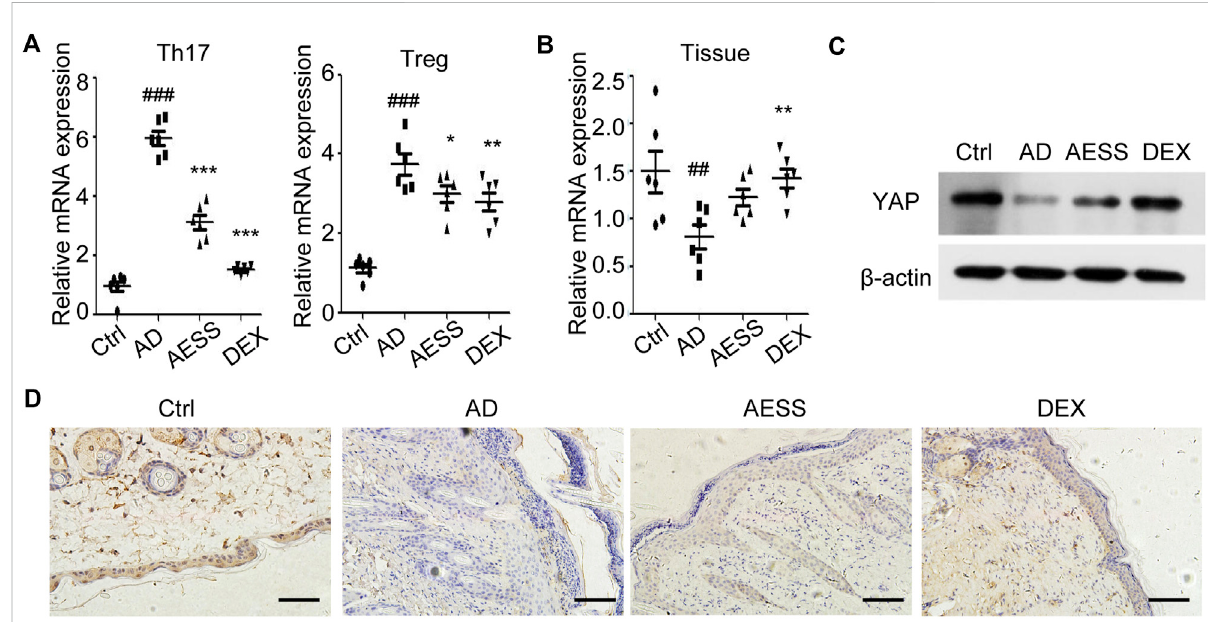
FIGURE 4 AESS formula could inhibit YAP expression in Th17 and Treg cells and induce YAP expression in epidermis of AD mice model. (A) Relative YAP protein expression in Th17/Treg cells from spleen mononuclear cells of mice. (B) Relative YAP mRNA expression in skin tissues of mice. (C) Relative YAPproteinexpressioninskintissuesofmice. (D) ImmunohistochemicalanalysisofYAPexpressionintheskinofmice.Scalebar=100 μ mqRT-PCR for three replicates. Number of animals = 6. Ctrl: Control mice; AD: Atopic dermatitis model mice; AESS: Mice intragastrically administered of 14.27 g/kg AESS formula; DEX: Mice intragastrically administered of 1 mg/kg dexamethasone. ## p < 0.01, ### p < 0.001 v. s. Ctrl; * p < 0.05, ** p < 0.01, *** p < 0.001 v. s. AD.